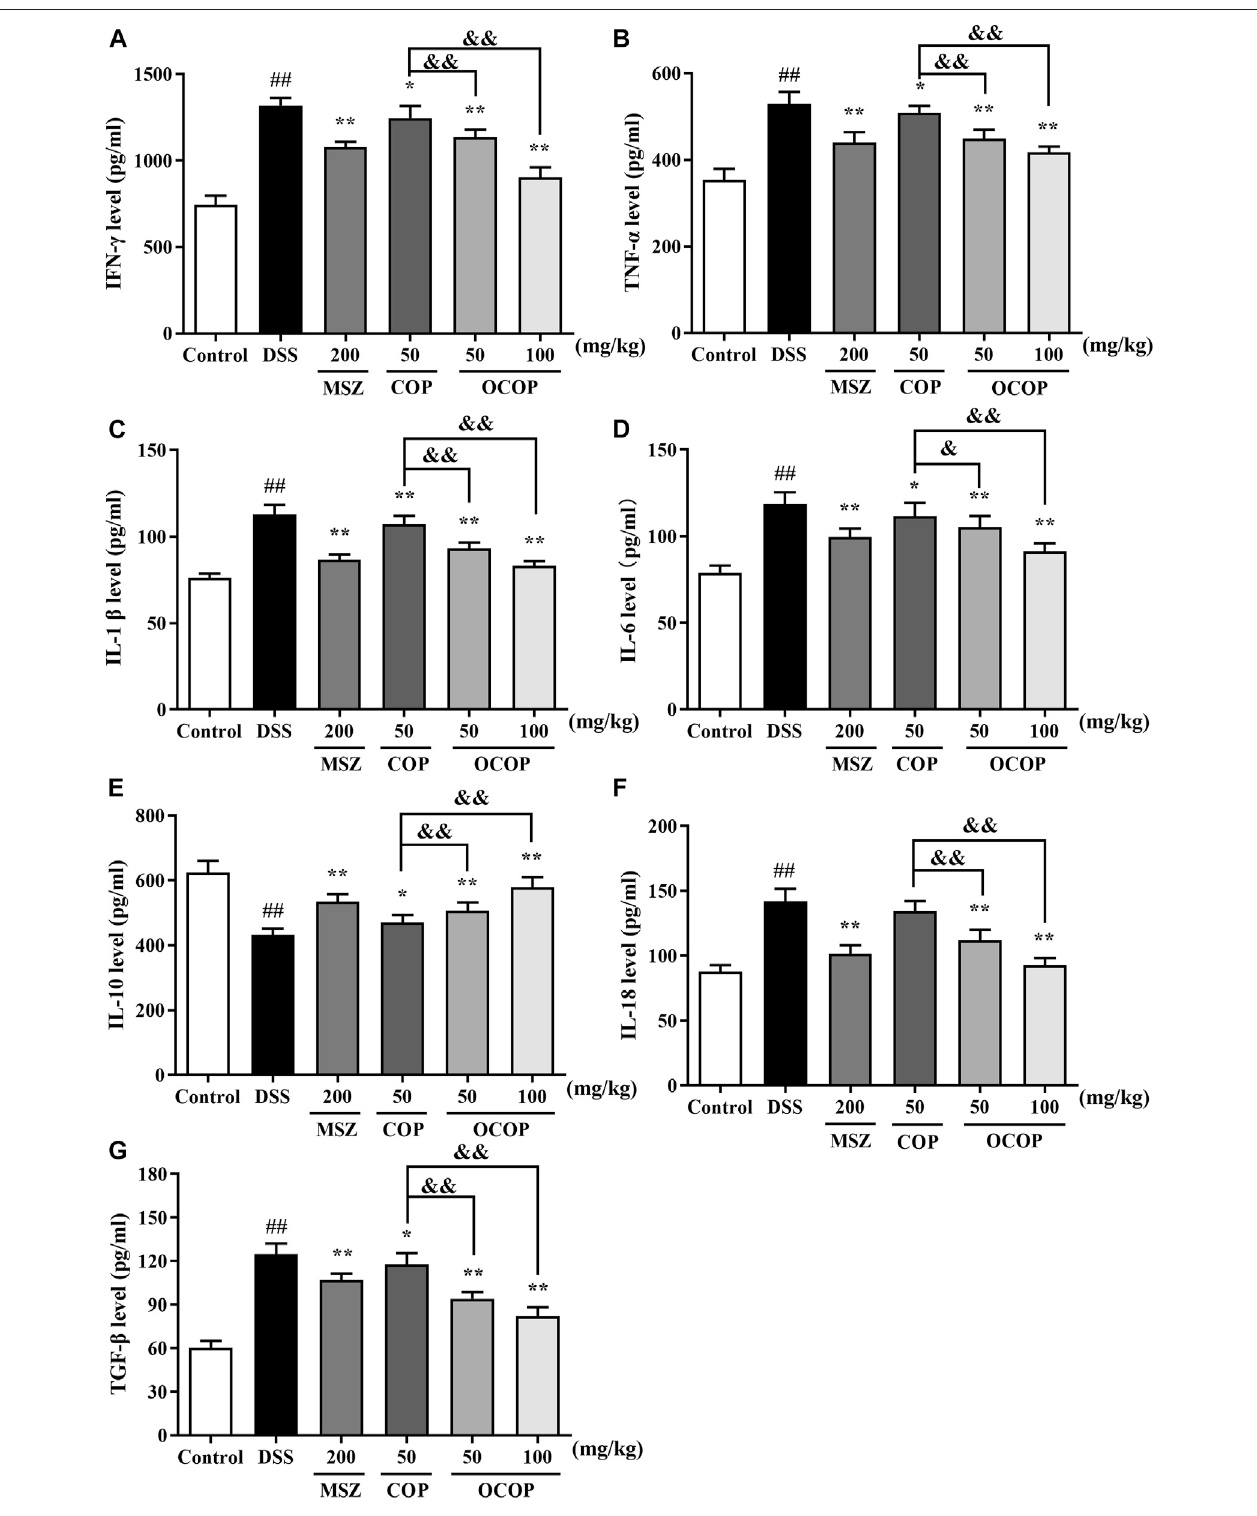
FIGURE4| EffectsofOCOP(50and100 mg/kg)andCOP(50 mg/kg)ontheproductionsofin fl ammatorycytokinesIFN- γ (A) ,TNF- α (B) ,IL-1 β (C) ,IL-6 (D) ,IL-10 (E) ,IL-18 (F) andTGF- β (G) incolontissuesofDSS-inducedmice.AfterDSSchallenge,treatmentswereadministeredonceadaybyintragastricgavageforaweek.Data are expressed as the means ± SD (n (cid:2) 10). # p < 0.05, ## p < 0.01 vs. control group; * p < 0.05, ** p < 0.01 vs. DSS group; & p < 0.05, && p < 0.01 vs. COP group.